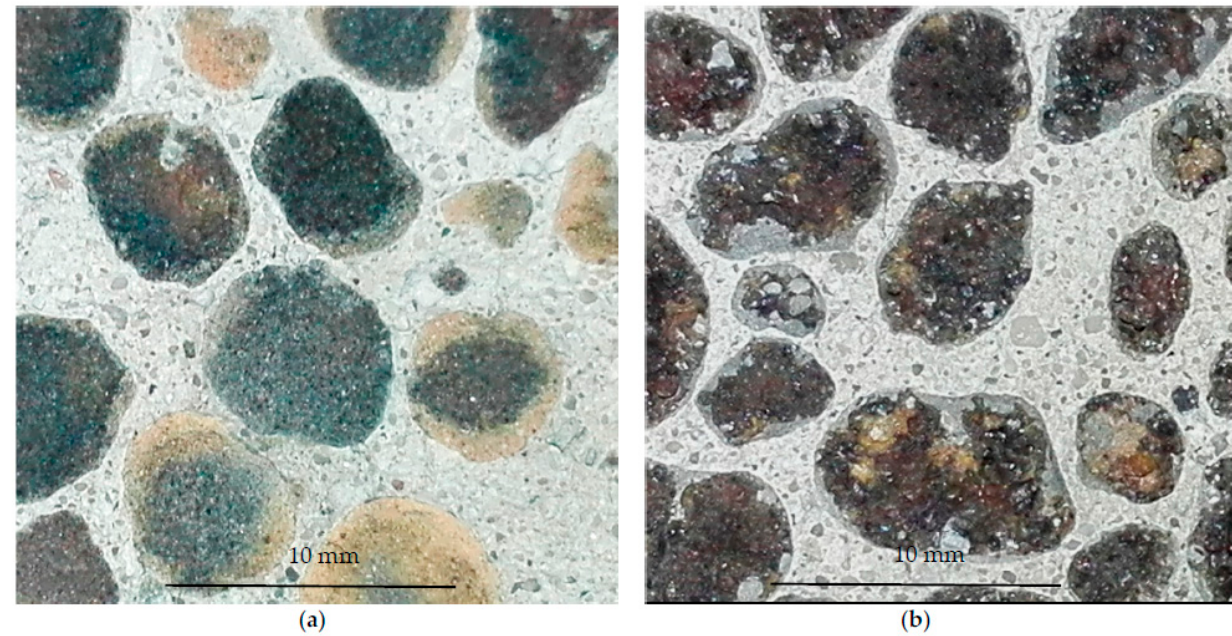
Figure 14. Appearance of a fracture in lightweight concretes with impregnated aggregates ( a ) Lytag 4/8 mm (Ly1d-1) and ( b ) Leca 4/8 mm (Le1d-1), subject to compression.